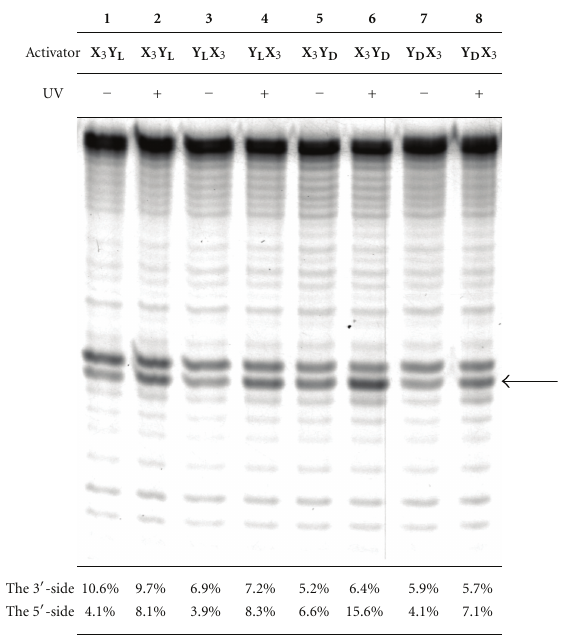
Figure 6: A denaturing 20% PAGE pattern for site-selective scission of 1 activated by 6 – 9 . Lane 1, 6 and Lu(III) without UV irradiation; lane 2, 6 and Lu(III) with UV irradiation; lane 3, 7 and Lu(III) without UV irradiation; lane 4, 7 and Lu(III) with UV irradiation; lane 5, 8 and Lu(III) without UV irradiation; lane 6, 8 and Lu(III) with UV irradiation; lane 7, 9 and Lu(III) without UV irradiation; lane 8, 9 and Lu(III) with UV irradiation. The 5 (cid:2) -side cleavage of U-19 is indicated by the arrow. Conversions of each scission are presented in the bottom. Reaction conditions; [RNA] = 5 μ M, [DNA] = 10 μ M, [LuCl 3 ] = 100 μ M, [Tris] = 10 mM, [NaCl] = 200mM, pH 7.5, 37 ◦ C, 7